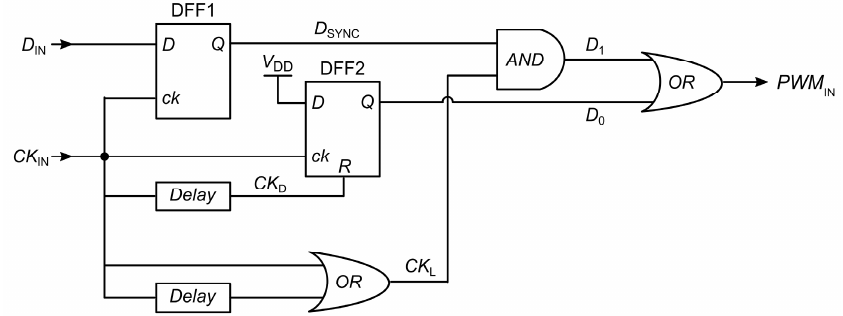
Figure 12. Simplified schematic of the TX baseband PWM modulator.